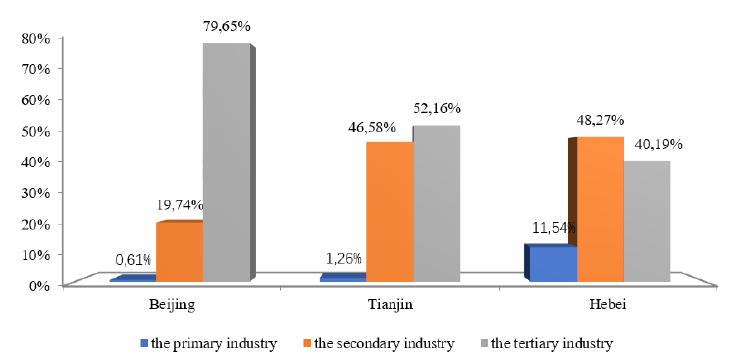
Fig. 1 The proportions of the industries in the sub-regions of Beijing, Tianjin and Hebei Province in